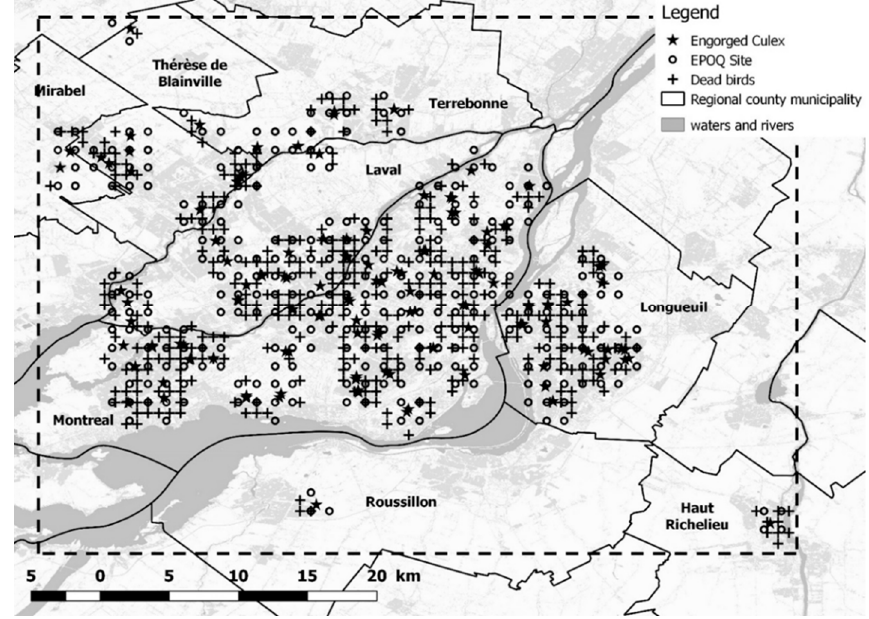
Figure 2. Study area with locations of collection of dead birds (CWHC), bird watching and counts (EPOQ) and collection of engorged female Culex pipiens–restuans on the island of Montréal, Québec.